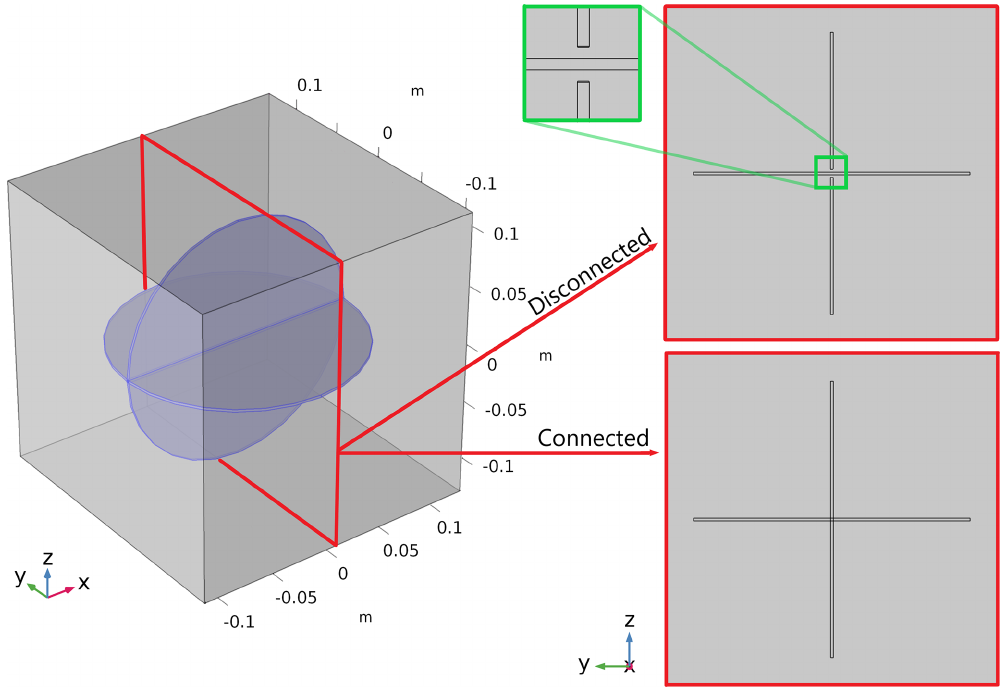
Figure 1. Sketch illustrating two flat cylinders representing two cracks. The blue region represents the pore space saturated with a fluid and the transparent gray area corresponds to the solid grain material. In the first model, the two cracks are disconnected as illustrated by the upper right sketch. In the second model, the two cracks are connected as illustrated by the lower right sketch.